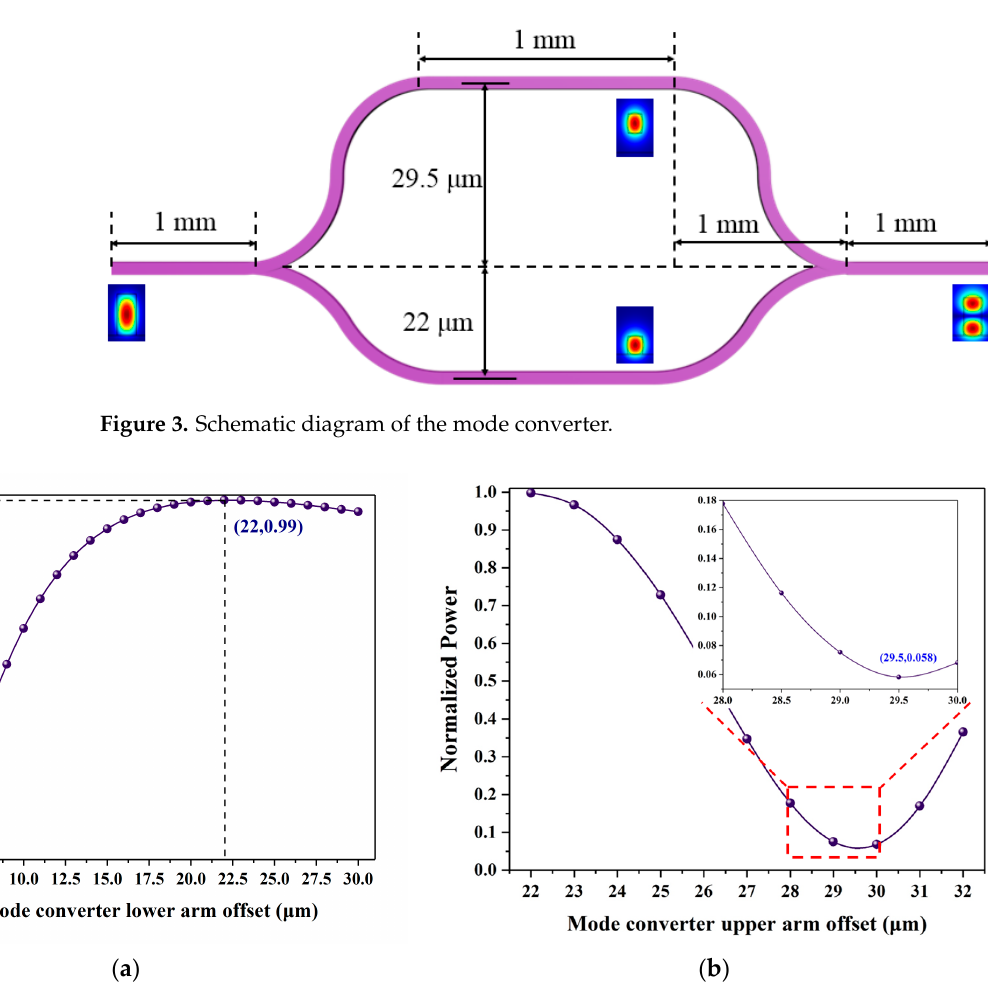
Figure 2. Relationship between the effective refractive index of different modes and the thickness of the polymer waveguide core.